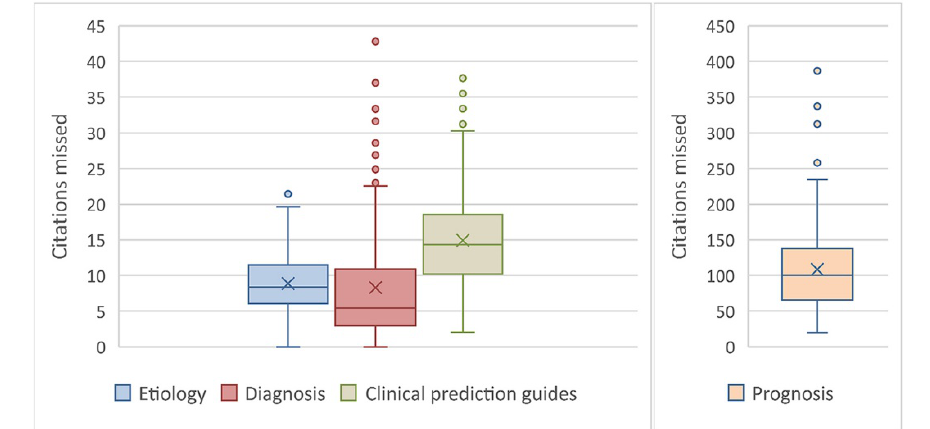
Figure 2 Filter /Narrow citations missed per 1,000 Filter /Broad in test queries